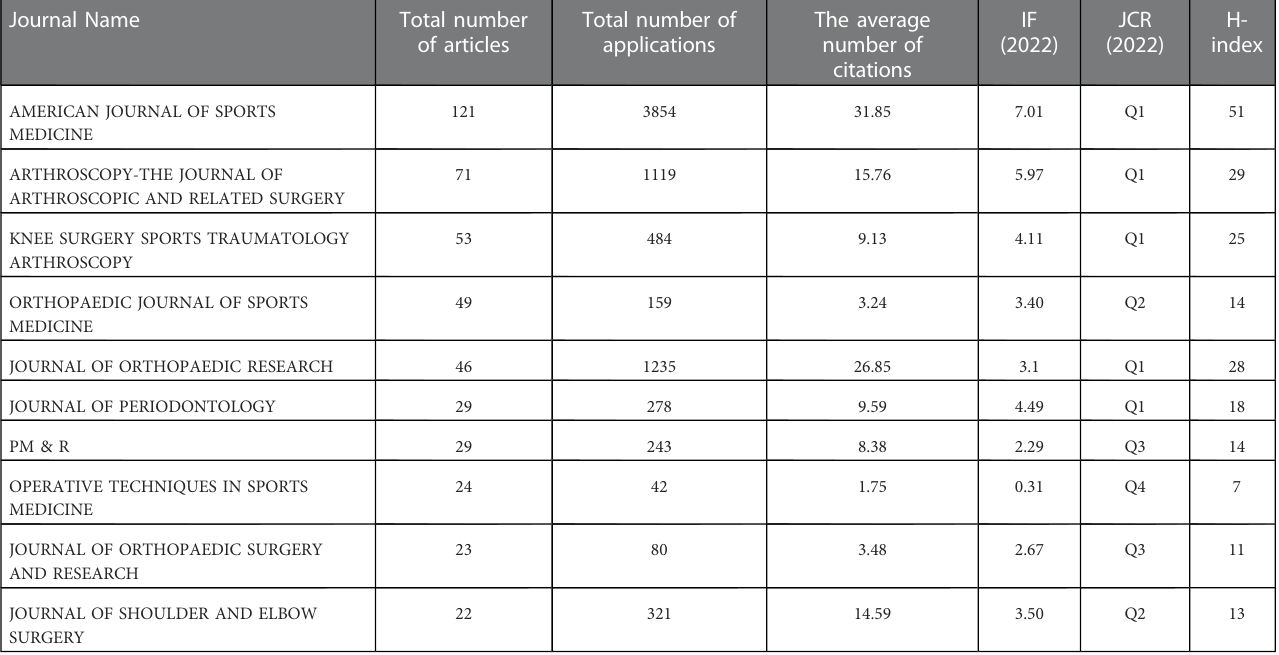
TABLE 3 Status of high-impact journals for platelet-rich plasma for tendon and ligament injury research,